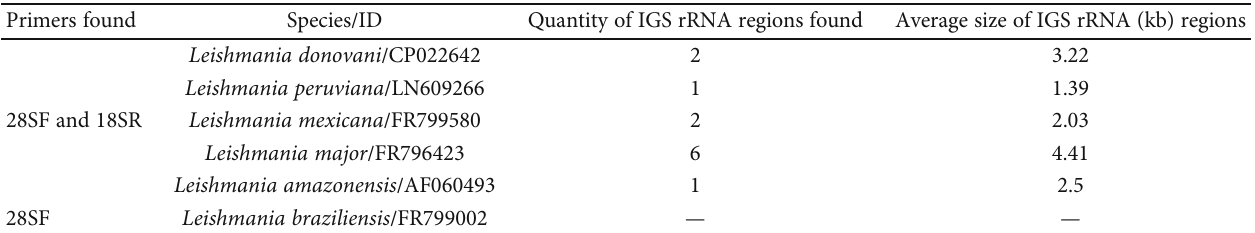
Table 3: Search results for BLAST n 28SF and 18SR primers.